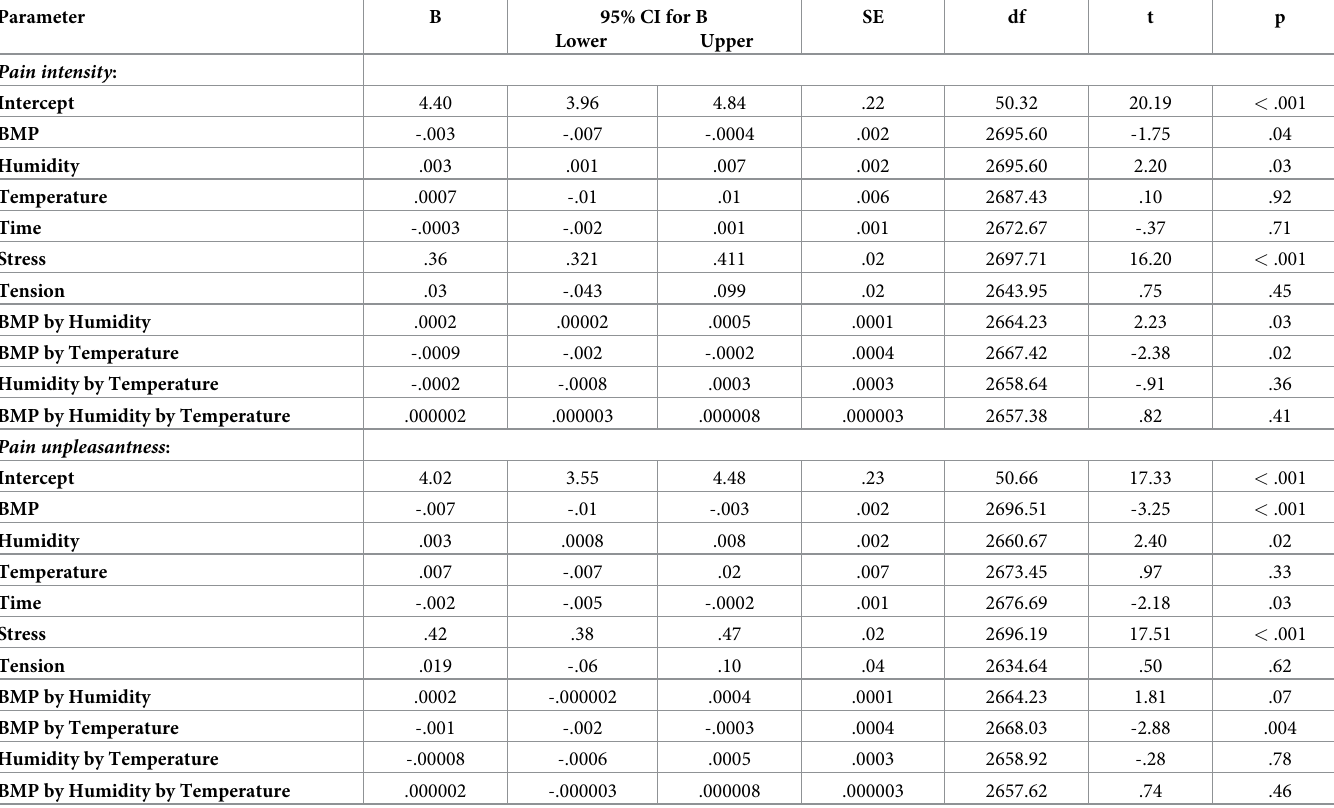
Table 3. Linear mixed model analysis for pain intensity and pain unpleasantness reports.